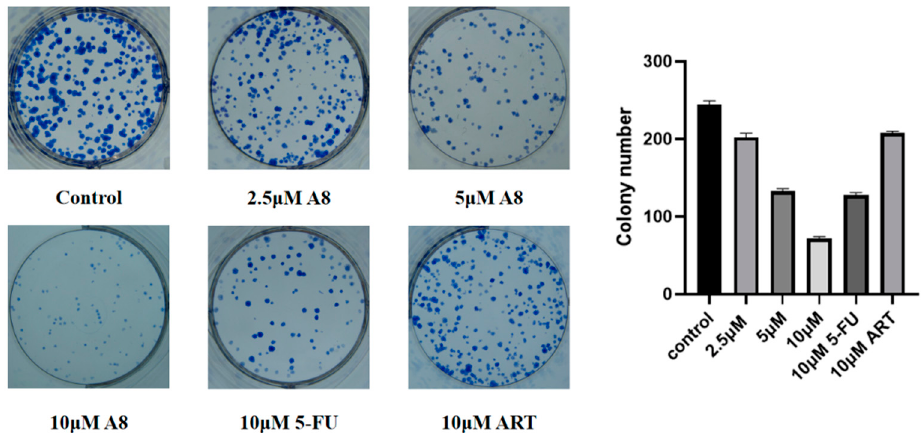
Figure 2. The effect of A8 , 5-FU and ART towards MCF-7 cell colony number; 5-FU and ART were used as control.